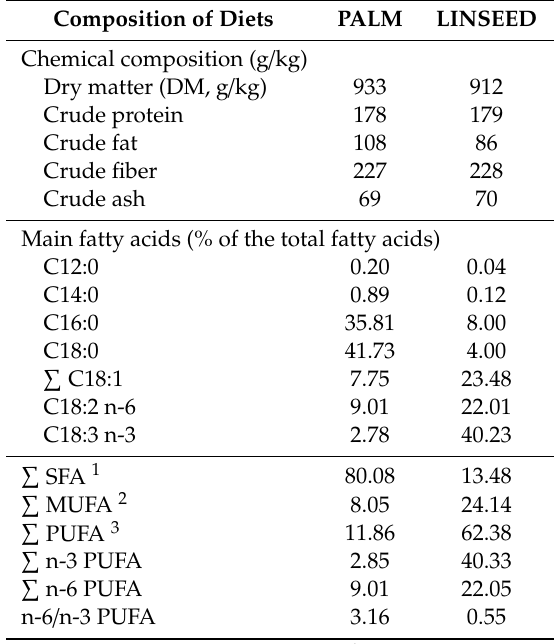
Table 2. Chemical composition and fatty acid composition of the diets. Composition of Diets